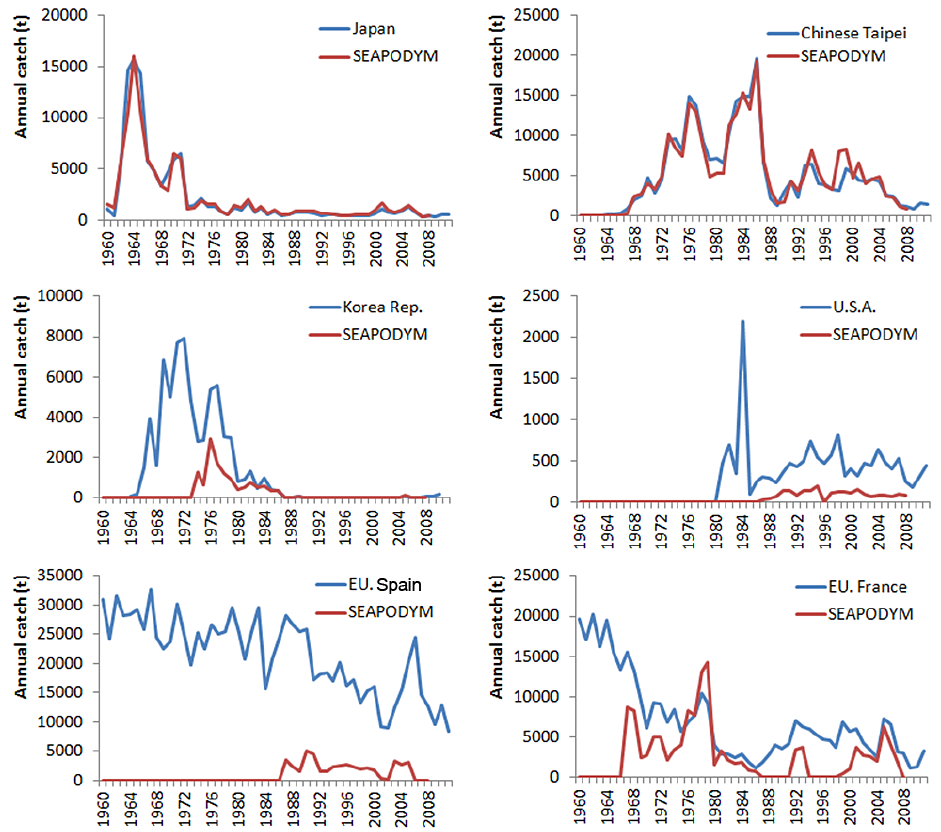
Figure 3. Time series of annual catch data with geographical coordinates used in the simulation with SEAPODYM and total annual catch declared to ICCAT for the main North Atlantic albacore tuna fisheries over the historical fishing period. When data were declared in number of fish, a conversion factor has been used, i.e., 16kgfish − 1 for Japanese, Chinese Taipei and US longline, and 8kgfish − 1 for French and Spanish surface